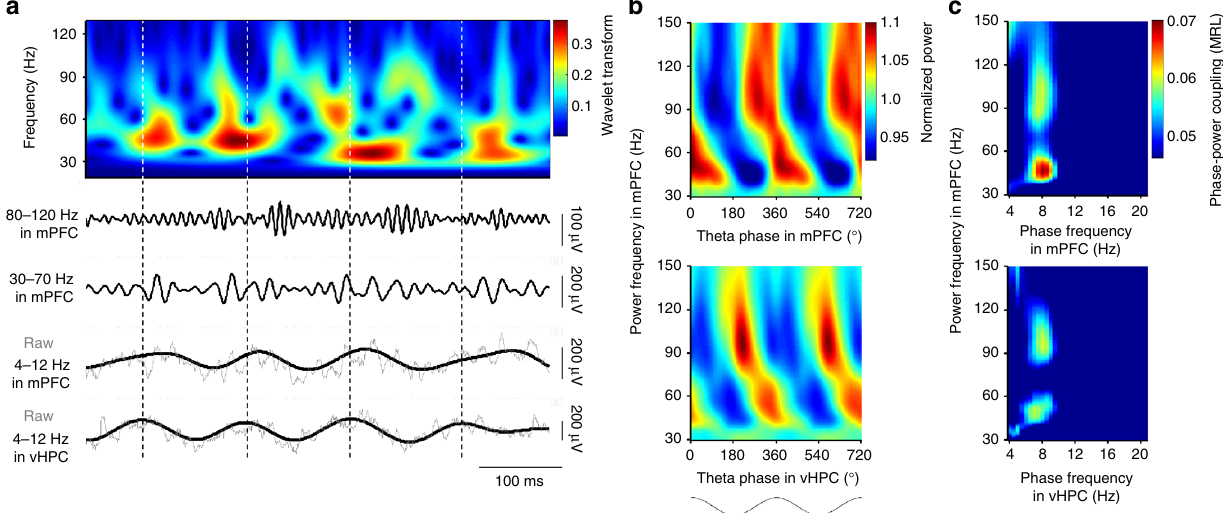
Fig. 1 Hippocampal theta oscillations modulate prefrontal gamma oscillations. a Top: an example wavelet transform of local fi eld potentials in the mPFC. Bottom: fast (80 – 120 Hz) and slow (30 – 70 Hz) gamma oscillations in the mPFC and raw LFP and theta (4 – 12 Hz) oscillations in the mPFC and vHPC. Dashed lines illustrate peaks of vHPC theta cycles. b Color-coded gamma power in the mPFC as a function of theta phase in the mPFC (top) and vHPC (bottom). Fast and slow gamma oscillations in the mPFC were seen coupled with distinct phases of theta oscillations in both of the vHPC and mPFC. c Phase-power comodulogram between fast-frequency power in the mPFC and low-frequency oscillation phase in the mPFC (top) and vHPC (bottom), demonstrating both of prefrontal and ventral hippocampal theta oscillations modulate the two separate ranges of gamma power in the